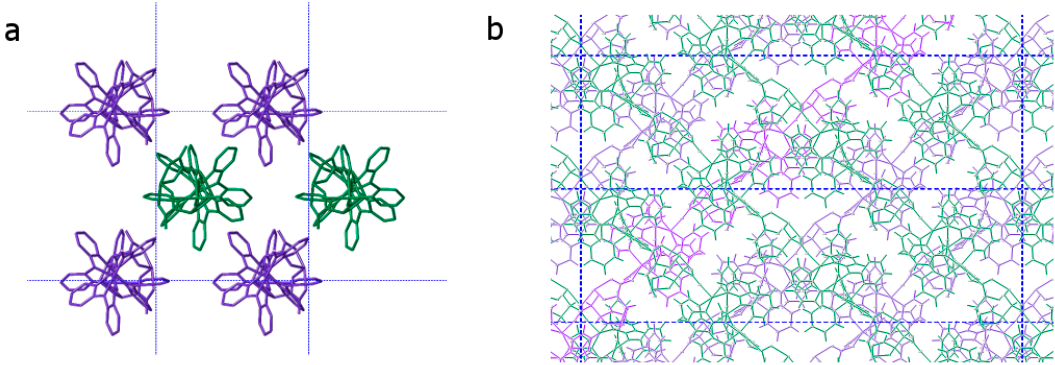
Figure 4. ( a ) Representation of ( a ) Δ - 1 along the crystal c axis, ( b ) Λ - 2 along the crystal c axis. Green and violet polymers are related to each other by a two-fold screw ( a ) or rotation ( b )